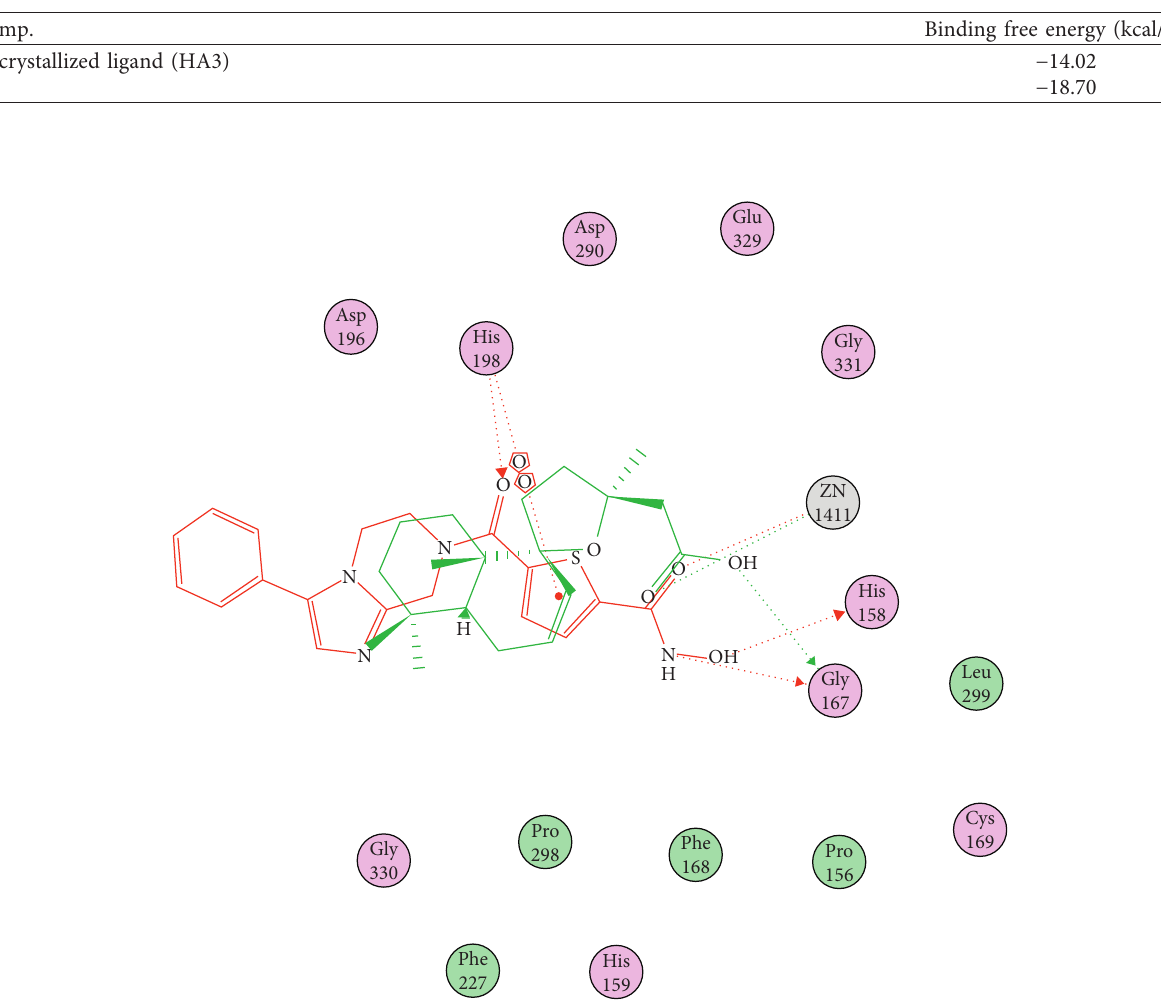
Figure 3: 2D overlay binding of compound 1 and the cocrystallized ligand against